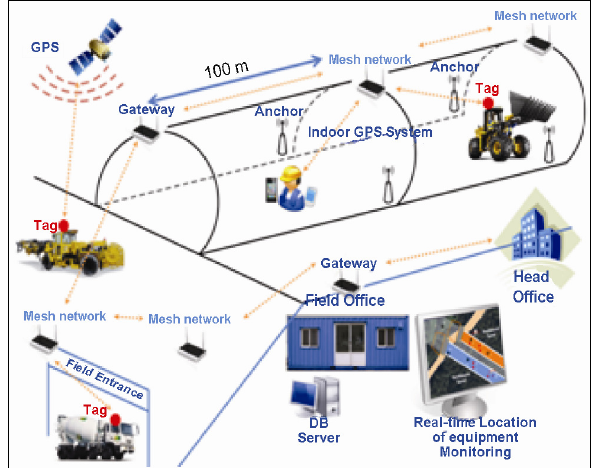
Fig. 3. Wireless mesh network system installed in a tunnel project